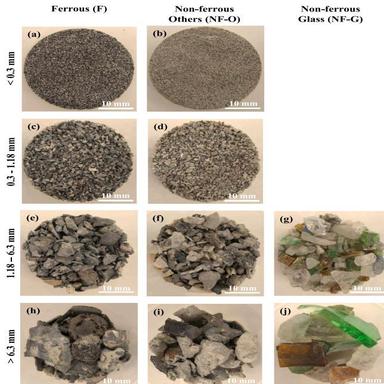
Typical appearance of classified IBA.